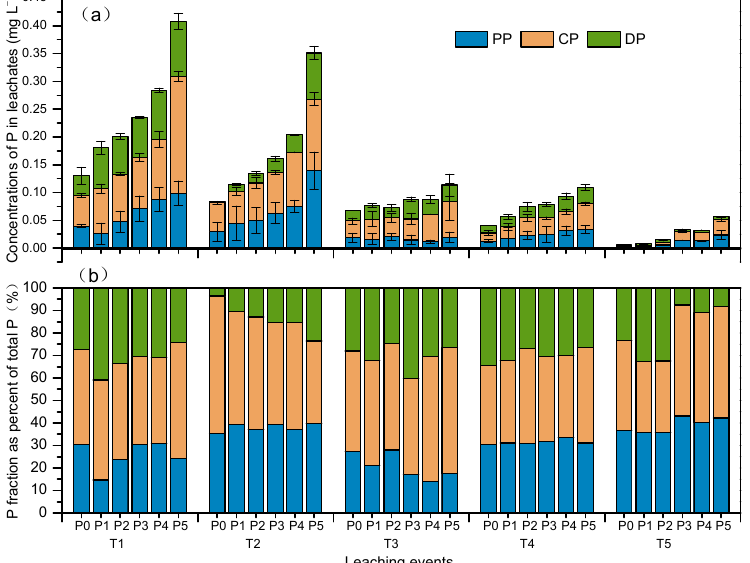
Figure 3. Phosphorus (P) concentrations in leachates ( a ) and P fraction as percent of total P ( b ) at different treatments. Phosphorus fertilizer levels at 0 (P0), 20 (P1), 40 (P2), 100 (P3), 200 (P4), and 400 (P5) mg kg − 1 , respectively, and the soil columns were conducted at 7 days (T1), 14 days (T2), 21 days (T3), 28 days (T4), and 56 days (T5).